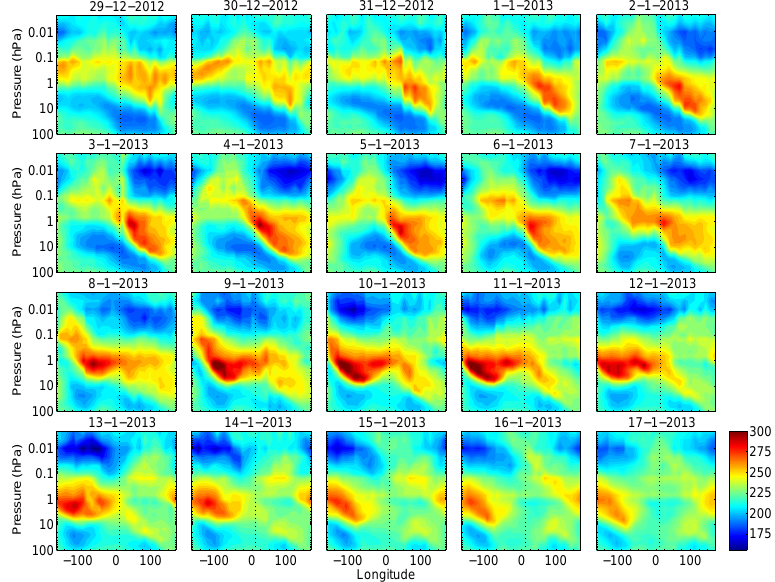
Figure 3. Longitudinal temperature distribution for a 15 ◦ latitude band centred around 63 ◦ N, from 29 December until 17 January. The temperatures have been determined for non-overlapping 15 ◦ longitude bands between − 180 ◦ (Western Hemisphere) and 180 ◦ (Eastern Hemisphere). The longitude of Trondheim has been highlighted with a dotted line. Note the difference in colour scale in comparison to Fig. 2. The SSW onset was on 7 January (de Wit et al., 2014b).